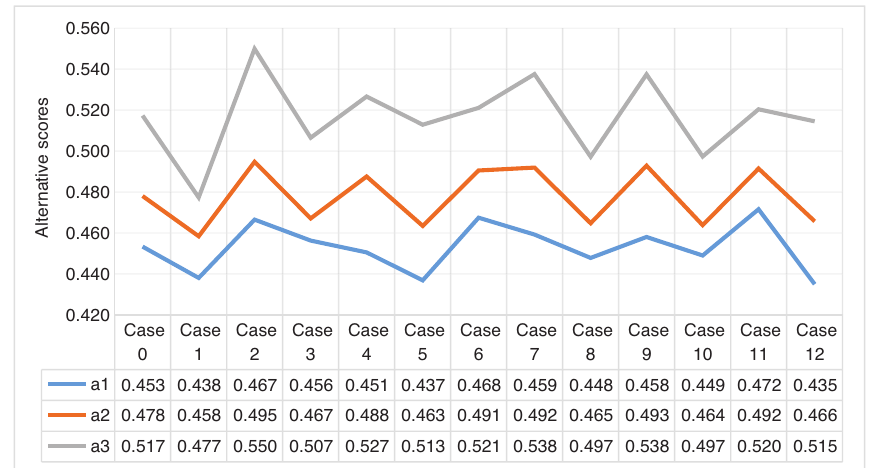
Figure 1: Sensitivity Analysis Results when the Weights of Criteria are Changed.